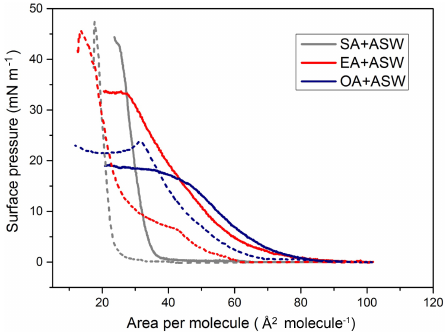
Figure 3. Surface pressure–area ( π – A ) isotherms of SA, EA, and OA monolayers on ASW (solid line) and ASW containing IC (short dashed line)